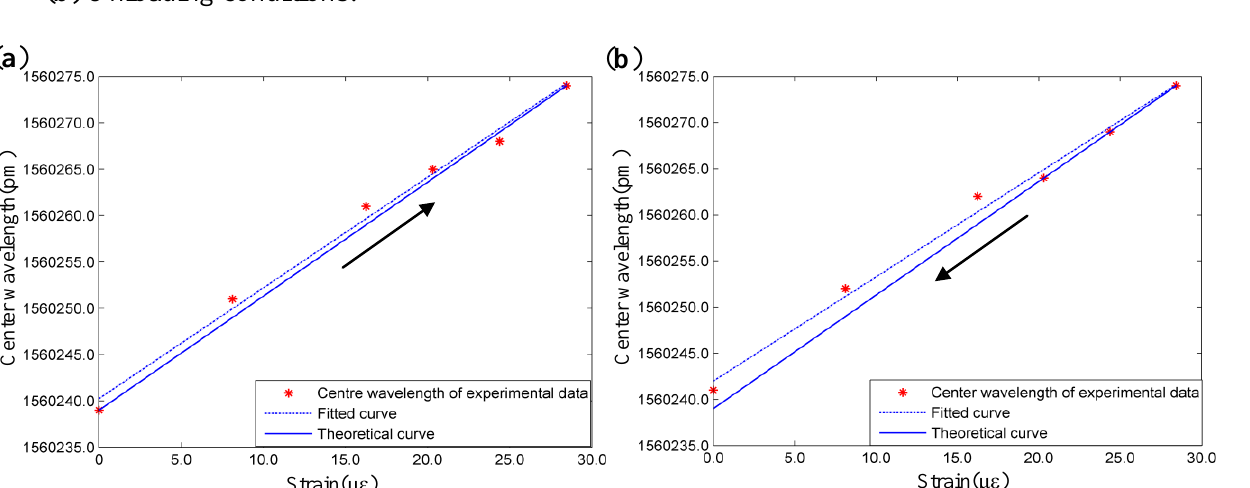
Figure 7. Sensitivity experiment of the FBGs sensor: ( a ) Loading